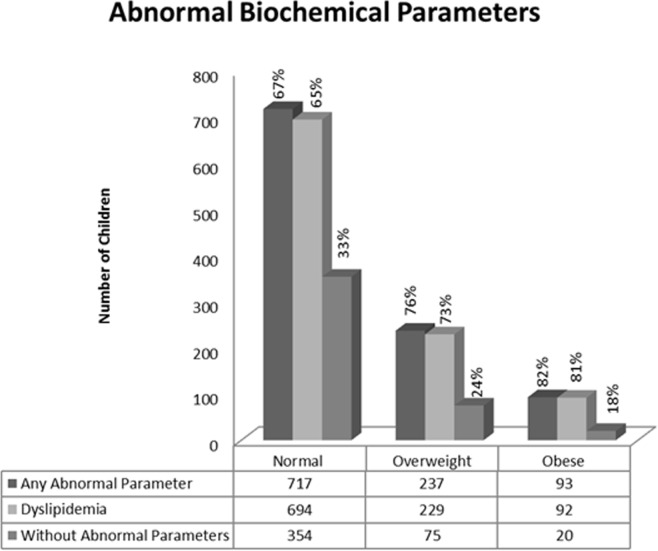
Distribution of abnormal biochemical parameters according to IOTF category.